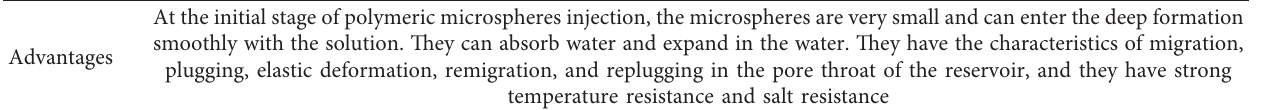
Table 2: Advantages and disadvantages of profile control of polymeric microspheres.